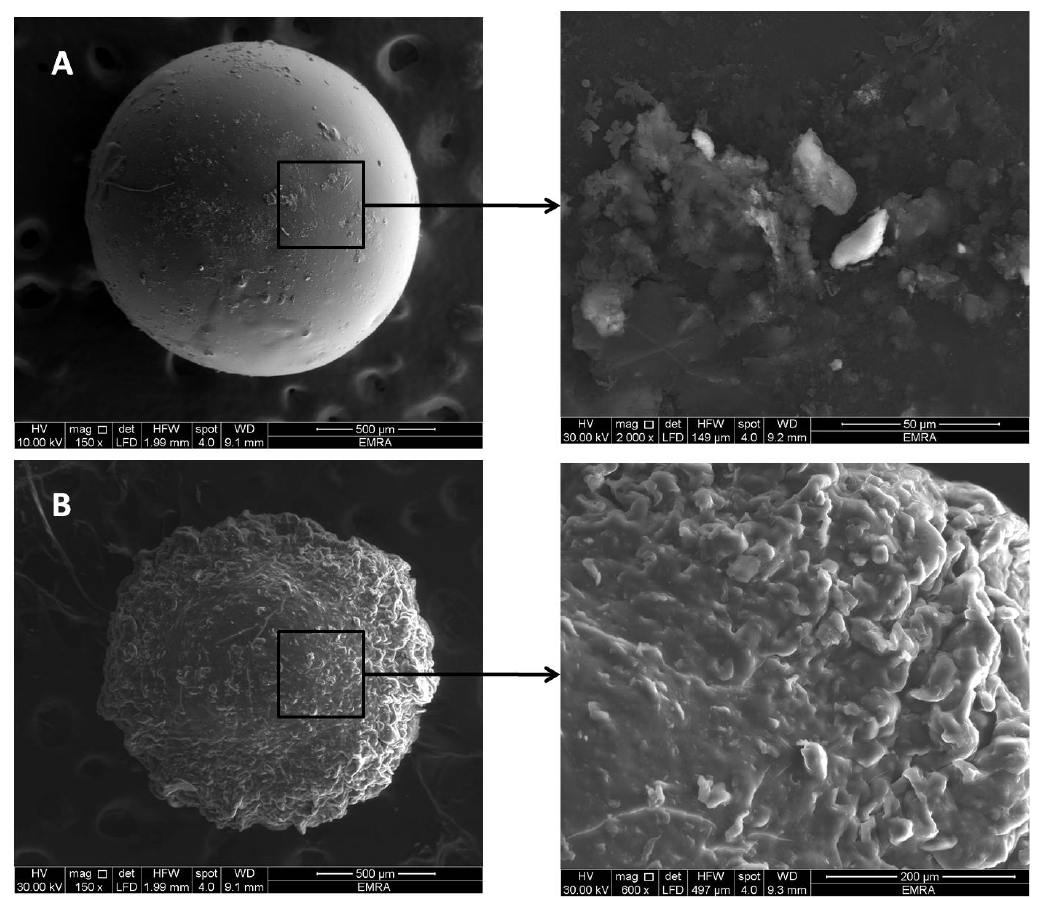
Figure 9. Images of ( A ) F8 Ch-based beads and ( B ) F8/3.58 Ch/Kc-PEC-based beads.